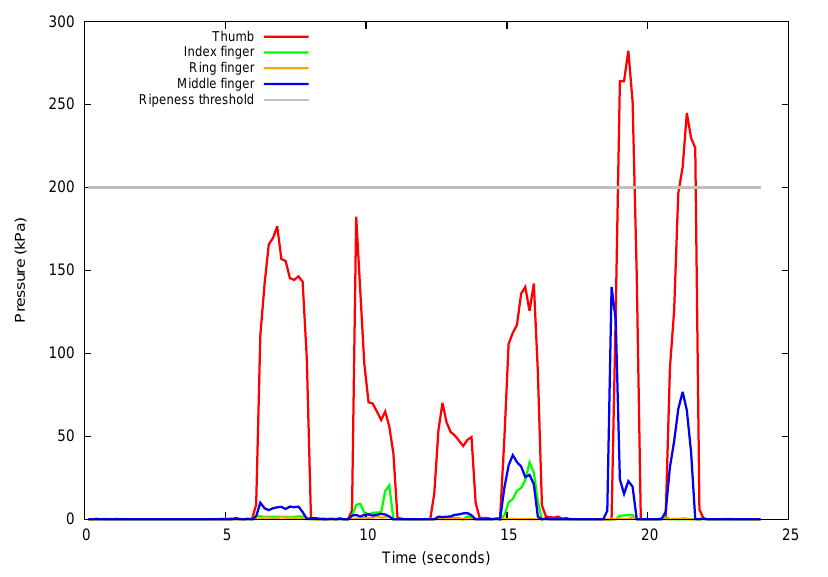
Figure 10. FSR sensor response during grasping of 6 tomatoes. Each peak represents the pressure of a grabbed tomato that is ripe, ripe, spoiled, ripe, unripe and unripe,